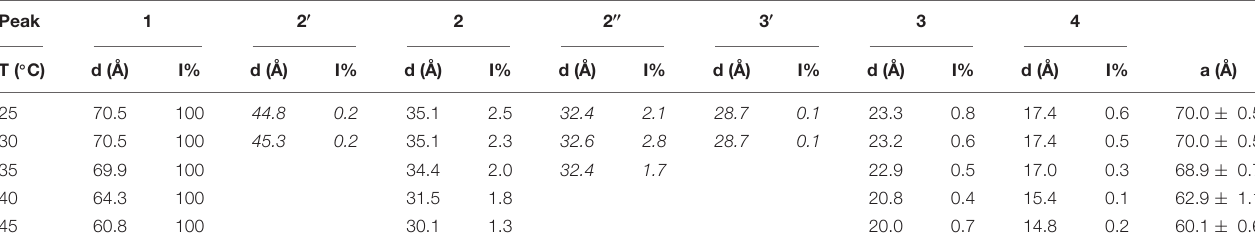
TABLE 1 | Effect of temperature on the lamellar structures for 70 wt% porcine brain sphingomyelin in water containing 0.9 wt% (154 mM) NaCl and 1 mM CaCl 2 .